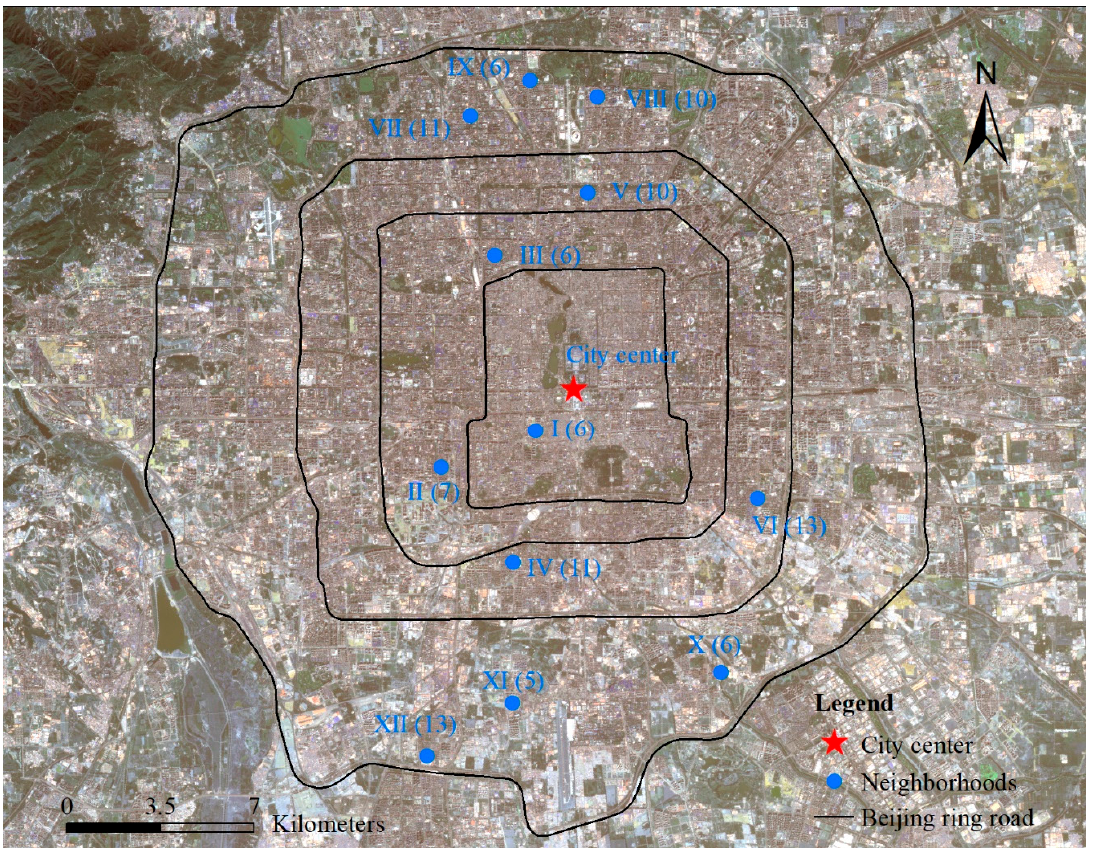
Figure 1. The location of neighborhoods investigated along the urban-rural gradient in Beijing. The numbers in parentheses indicate the numbers of patches investigated in the neighborhood. I: Chunshuyuan; II: Xiaohongmiao; III: Jindianhuayuan; Ⅳ : Jiayuanerli; Ⅴ : Anzhenxili; Ⅵ : Songyudongli; Ⅶ : Dongwangzhuang; Ⅷ : Huizhongbeili; Ⅸ : Lincuixili; Ⅹ : Delinyuan; Ⅺ : Nantingxinyuan; Ⅻ : Ruihaijiayuan.